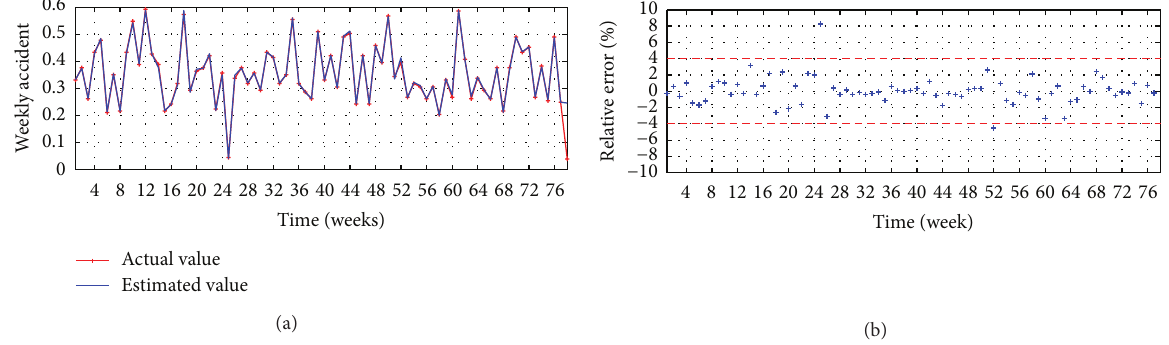
Figure 16: HSVD-ANN-RPROP(9,11,1): (a) observed versus estimated and (b) relative error.